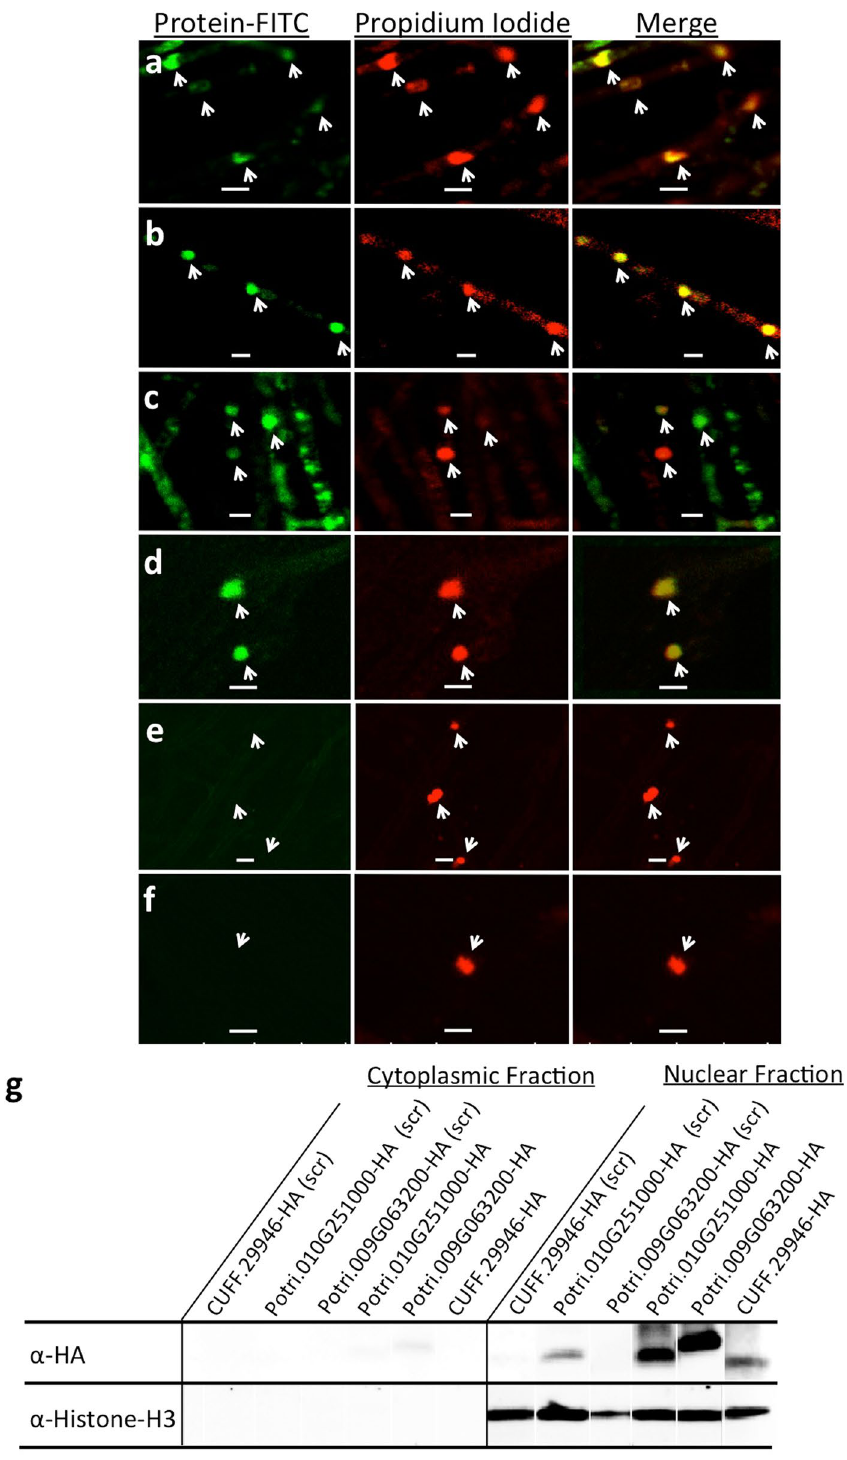
Figure 4. Uptake and sub-cellular localization of Populus trichocarpa small secreted proteins (SSPs) into Laccaria bicolor hyphae. L. bicolor colonies were incubated with 1 µ M of either FITC-labelled SSP or FITC alone (control) in PBS (pH 7) for 4 hours after which they were rinsed briefly in PBS, fixed in 4% paraformaldehyde and then stained with 0.1% propidium iodide. Green signal indicates SSP-FITC (mature protein lacking secretion signal) florescent localization, red indicates propidium iodide fluorescence as a nucleus marker. Nuclei are marked by an arrow. ( a ) CUFF.29946; ( b ) Potri.009G063200; ( c ) Potri.010G251000; ( d ) Potri.007G006800; ( e ) Potri.019G121200; ( f ) FITC control; ( g ) Representative Western blot of cytoplasmic and nuclear protein extracted from L. bicolor exposed to either scrambled (scr) or native forms of CUFF.29946, Potri.009G063200 and Potri.010G251000 labeled with an HA tag. Probing for histone H3 shows purity of cytoplasmic fraction from nuclear